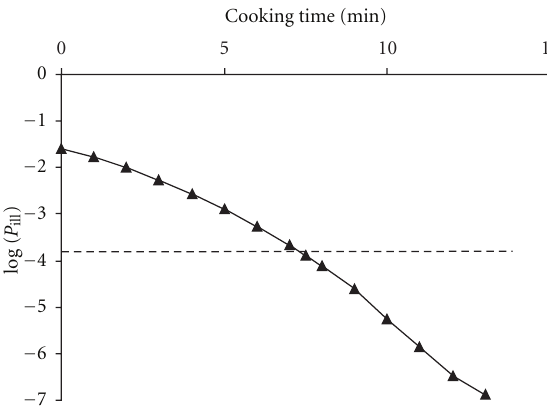
Figure 4: The probability of illness per consumed chicken breast fillet as a function of the cooking time. Results are obtained by a Monte Carlo simulation (400.000 runs for each cooking time t , given as a triangle) of (4), using the distribution of Campylobacters per fillet at retail level in The Netherlands, as found by Nauta et al. [33]. The dashed line shows the mean probability of illness per meal due to cross-contamination as found by these